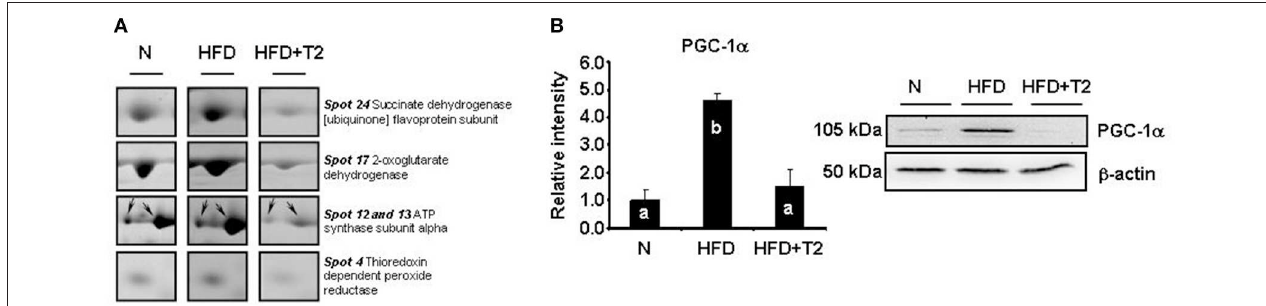
FIGURE 2 | Examples of differential representation of mitochondrial proteins and PGC-1 α in gastrocnemius muscle of N, HFD, and HFD + T2 rats. (A) Representative subsections of 2D-E images are shown as examples of differential representation of mitochondrial proteins between experimental groups. Spot numbering refers to Figure 1 . (B) Representative Western blot analysis of the expression levels of PGC-1 α in gastrocnemius muscle of N, HFD, and HFD + T2 rats. Data were normalized to the value obtained for N animals, set as 1, and presented separately for each treatment (means ± SD; n = 4/6). Bars labeled with dissimilar letters are significantly different ( P <